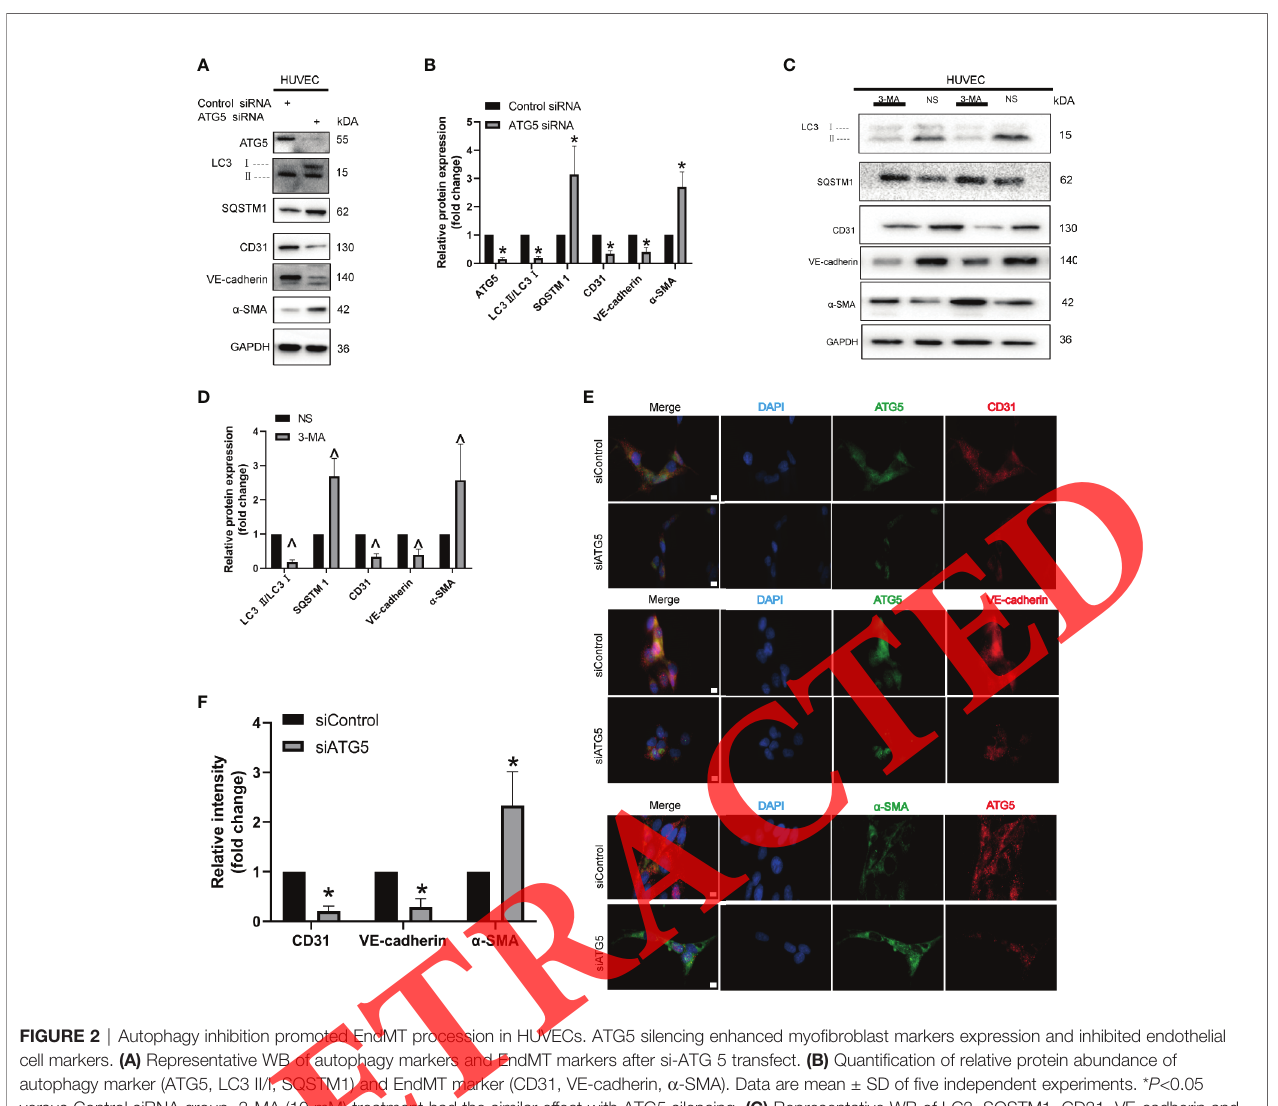
FIGURE 2 | Autophagy inhibition promoted EndMT procession in HUVECs. ATG5 silencing enhanced myo fi broblast markers expression and inhibited endothelial cell markers. (A) Representative WB of autophagy markers and EndMT markers after si-ATG 5 transfect. (B) Quanti fi cation of relative protein abundance of autophagy marker (ATG5, LC3 II/I, SQSTM1) and EndMT marker (CD31, VE-cadherin, a -SMA). Data are mean ± SD of fi ve independent experiments. * P <0.05 versus Control siRNA group. 3-MA (10 mM) treatment had the similar effect with ATG5 silencing. (C) Representative WB of LC3, SQSTM1, CD31, VE-cadherin and a -SMA. (D) Quanti fi cation of relative protein abundance of LC3 II/I, SQSTM1, CD31, VE-cadherin and a -SMA. Data are mean ± SD. ^ P <0.05 versus NS group. (E) Representative immuno fl uorescence staining of ATG5, CD31 and a -SMA indicated the same fi ndings with WB. Bar=20 m m. (F) Quanti fi cation of relative intensity of ATG5, CD31 and a -SMA. Data are mean ± SD. * P <0.05 versus Control siRNA